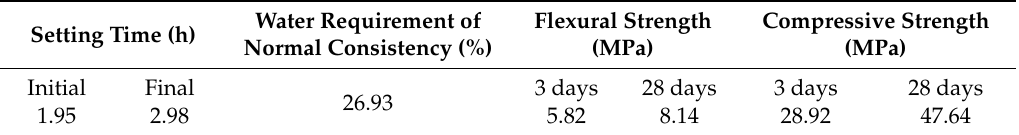
Table 2. Basic physical indexes of Portland cement.